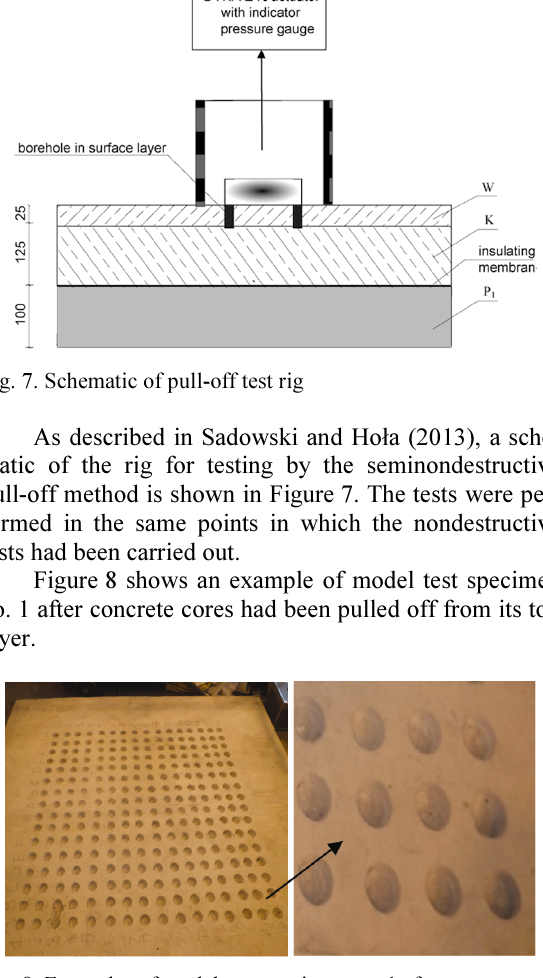
Fig. 8. Examples of model test specimen no. 1 after concrete cores had been pulled off from its top